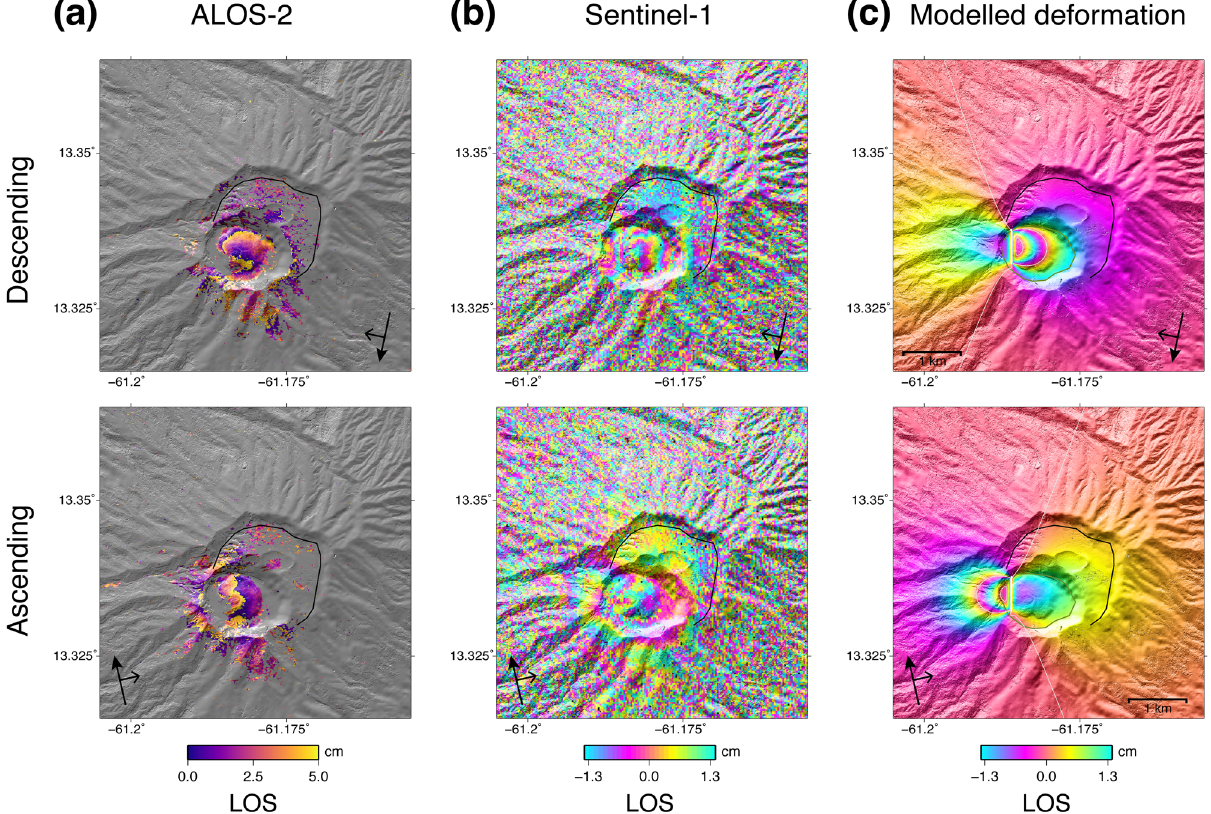
Fig. 5 Deformation associated with the 27 December 2020 extrusive eruption. These visualisations use the Grandin and Delorme (2021) DSM. a Interferograms for descending (2020/02/25 – 2021/01/26, path 131, frame 3350) and ascending (2020/01/15 – 2021/01/13, path 36, frame 250) ALOS- 2 radar. One fringe represents 11.4 cm in the line of sight; b Interferograms for descending pass (2020/12/07 – 2020/12/31, track 156, incidence 44.5°) and ascending (2020/12/07 – 2020/12/31, track 164, incidence 43.9°) Sentinel-1 radar. One fringe represents 2.8 cm in the line of sight; c Synthetic deformation predicted by an Okada dislocation dipping vertically (along-strike length: 600m, along-dip width: 700 m, upper edge depth: 15 m), opening with a potency of 63,000 m 3